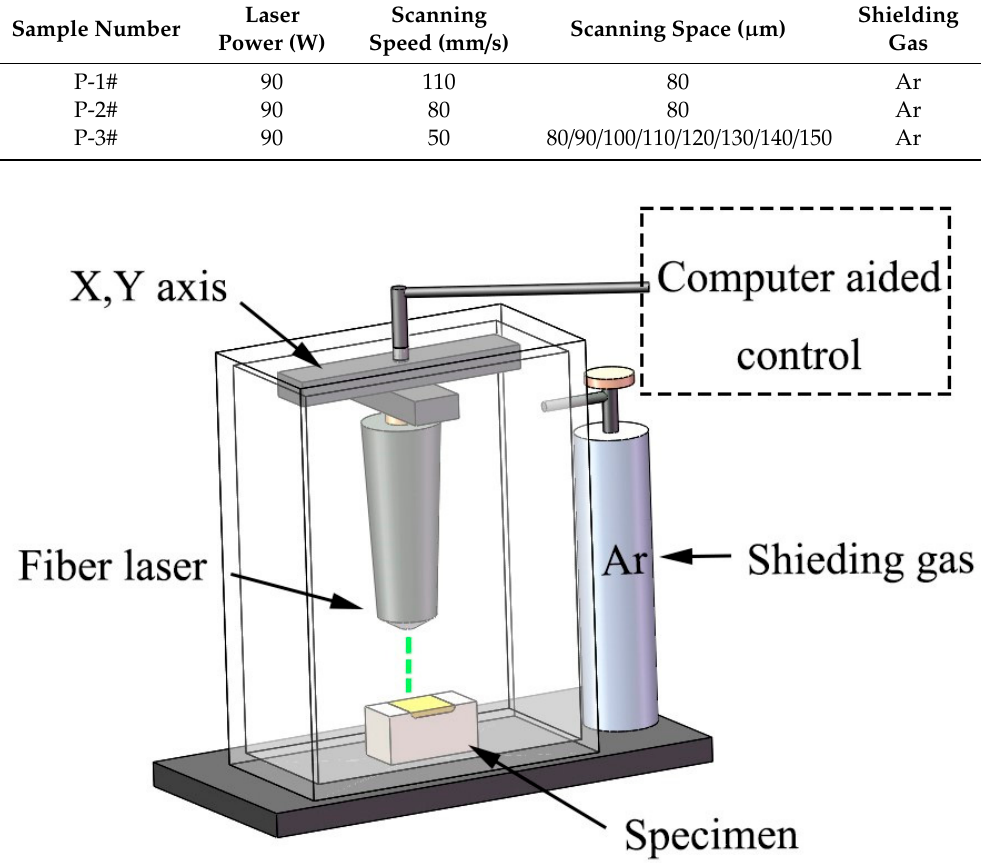
Figure 2. Equipment schematic of the LSR (laser surface remelting). Table 1. Chemical compositions of steel (wt%).